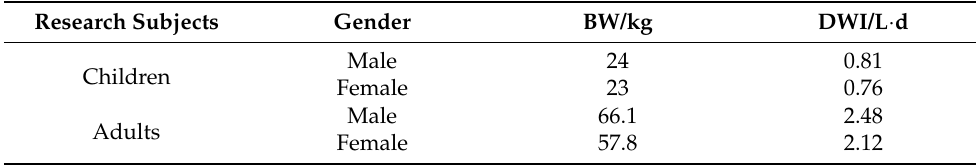
Table 2. BW and DWI values for adults and